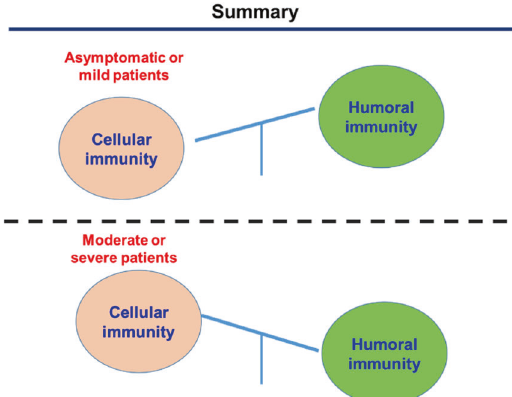
Fig. 6 Schematic summary of adaptive immunity of COVID-19 patients with different disease severity. (Up panel) Patients of asymptomatic or mild disease mount a predominant cellular immunity but low to no humoral immunity. (Lower panel) Patients of moderate or severe disease induce a potent humoral immunity, while fail to elicit an effective cellular